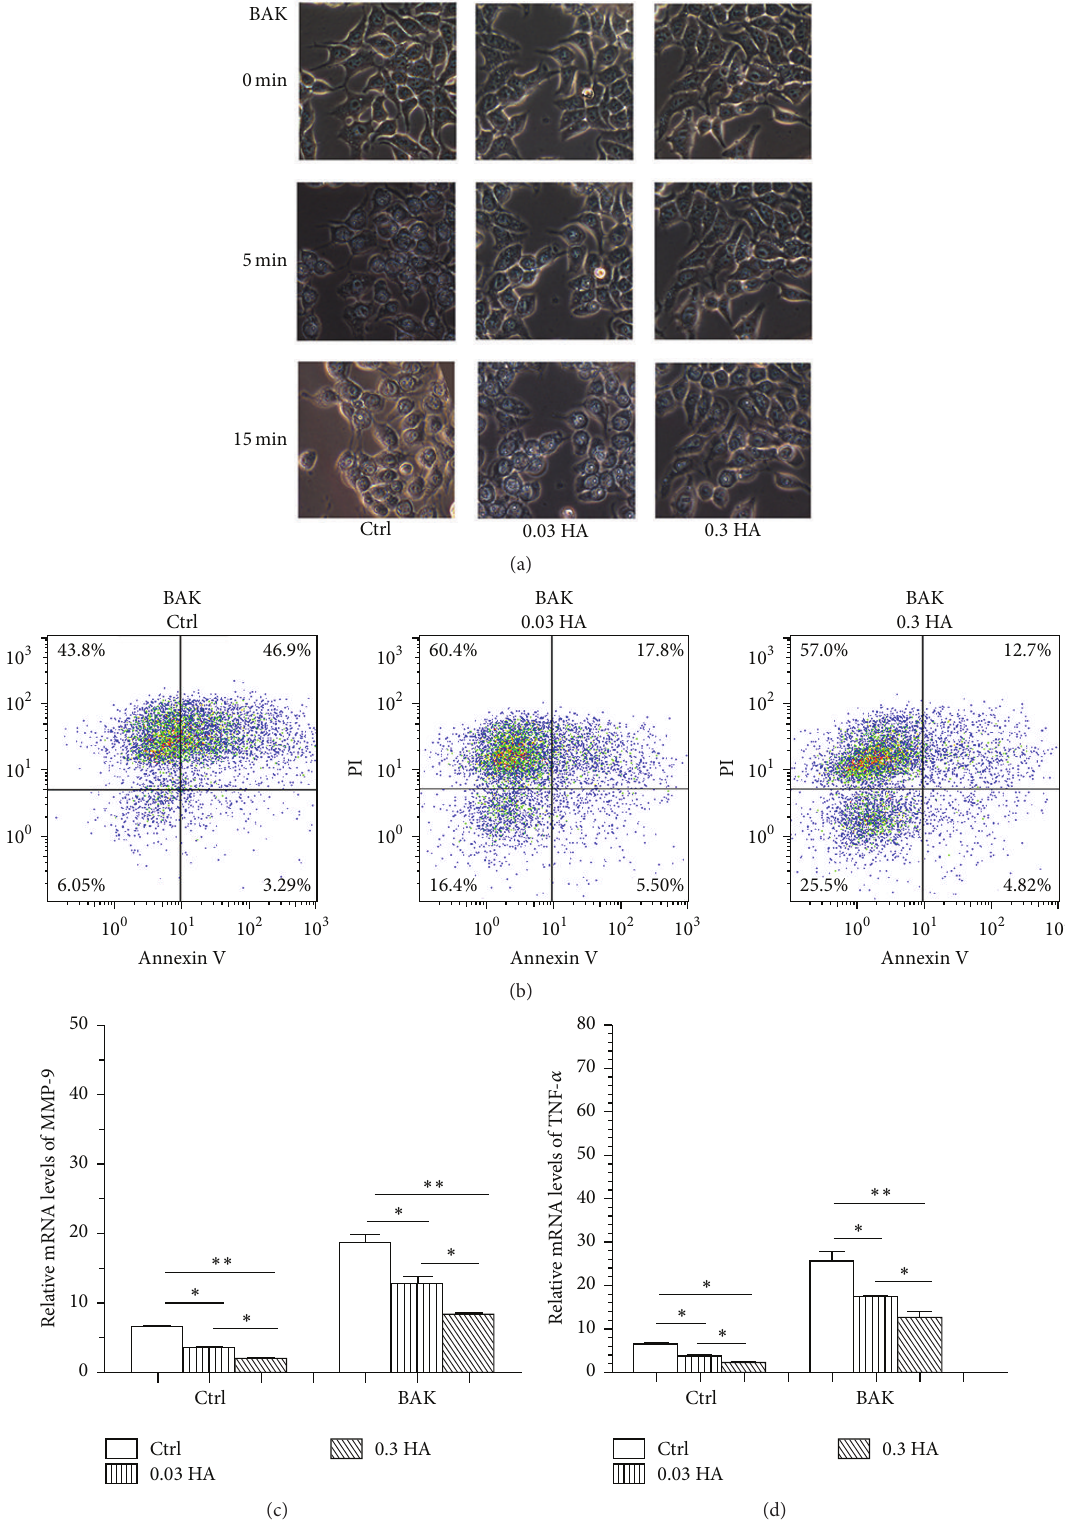
Figure 2: Hyaluronate decreased BAK-induced cell apoptosis and the expression of inflammatory cytokines. Microscopic images (a) of the changes in cell morphology in response to the hyperosmolar conditions were examined in the control, 0.03 HA, and 0.3 HA groups. Flow cytometry (b) was performed to analyse cell apoptosis, and real-time PCR (c) and (d) was used to compare the expression levels of MMP-9 and TNF- 𝛼 among the three groups. Magnification: × 100. ∗ 𝑝 < 0.05 ; ∗∗ 𝑝 < 0.01 ; ∗∗∗ 𝑝 < 0.001 . The data are the mean ± SEM and represent individual experiments, each including 5